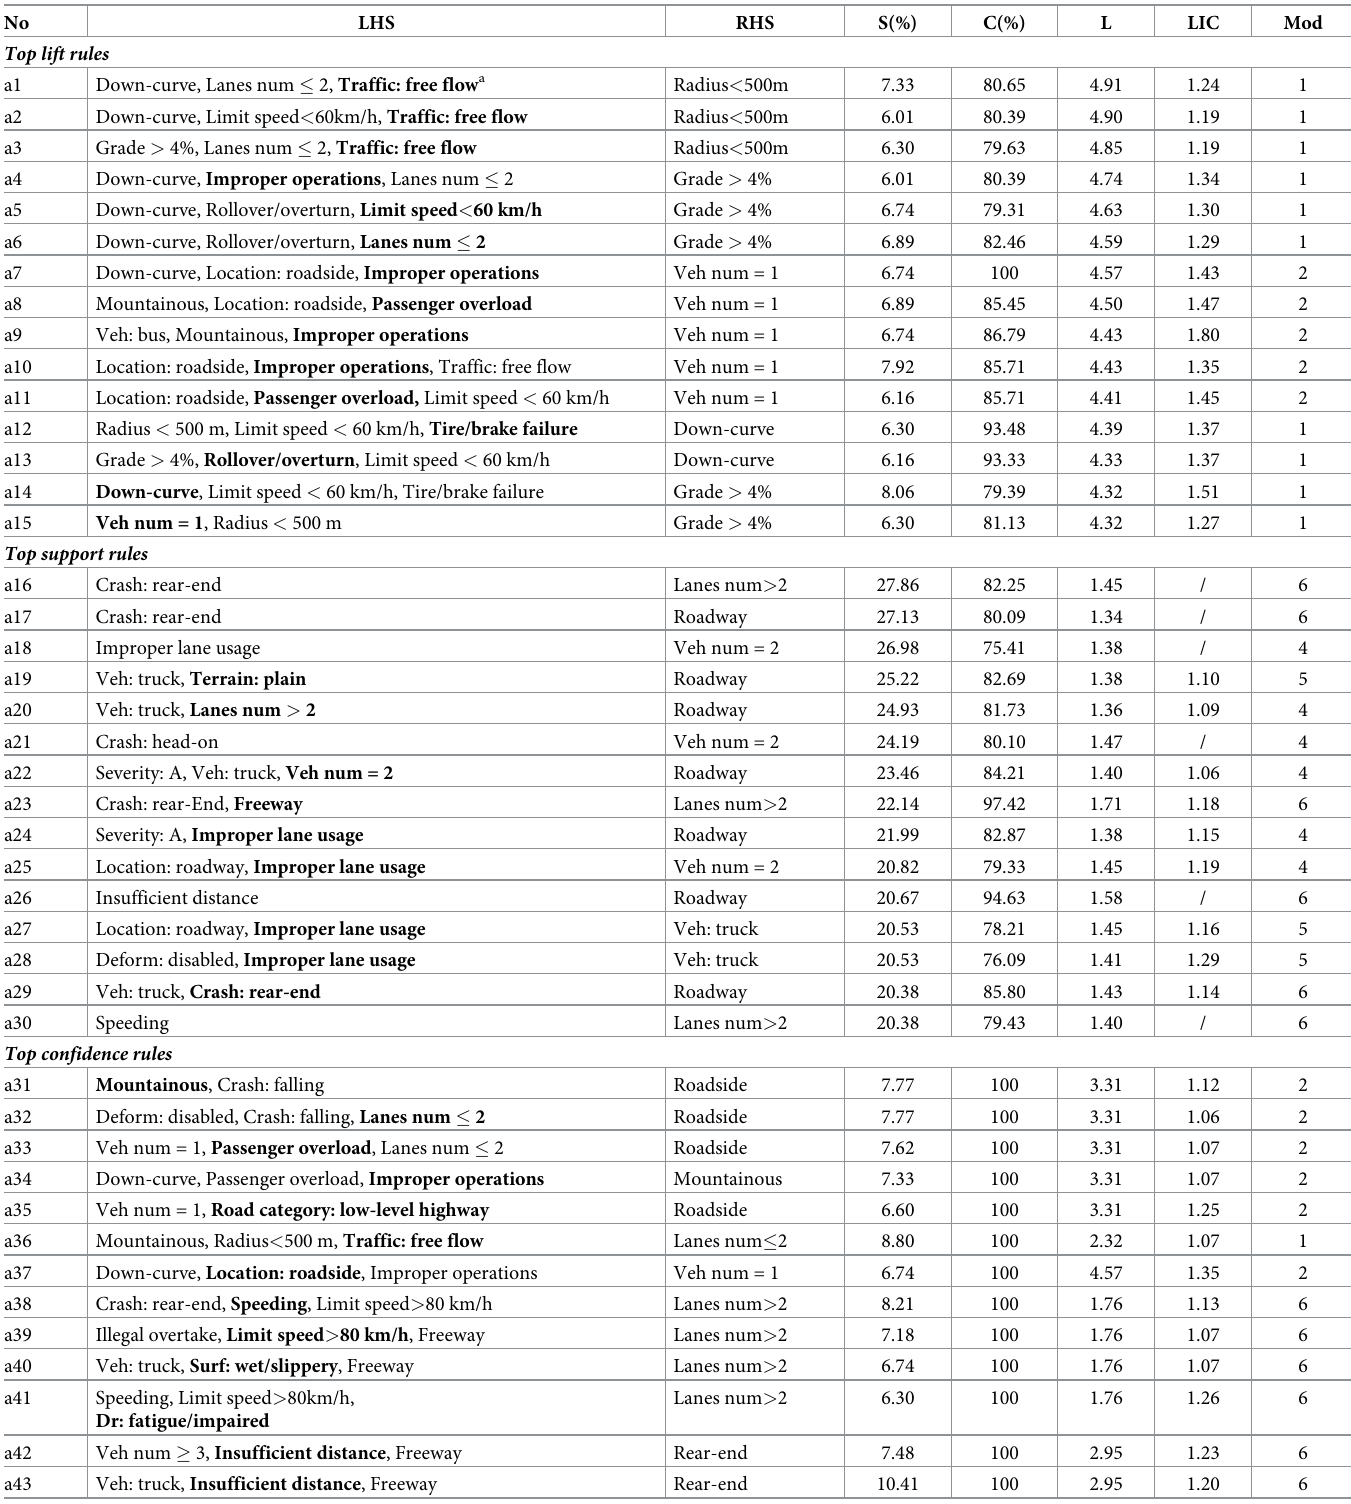
Table 3. Rules sorted by top indicator (lift, support, and